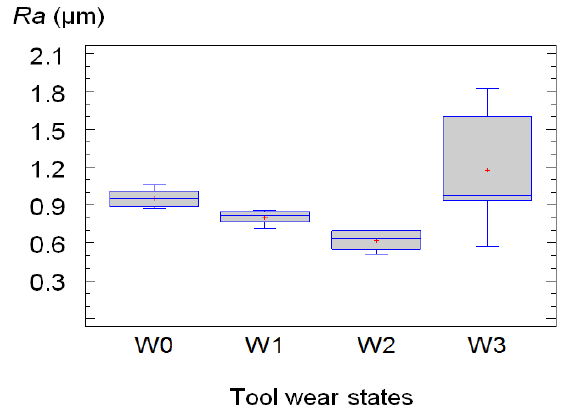
Figure 8. Boxes and whiskers plot of Ra for different levels of tool wear: Fresh tool (W0), wear state 1 (W1), wear state 2 (W2) and wear state 3